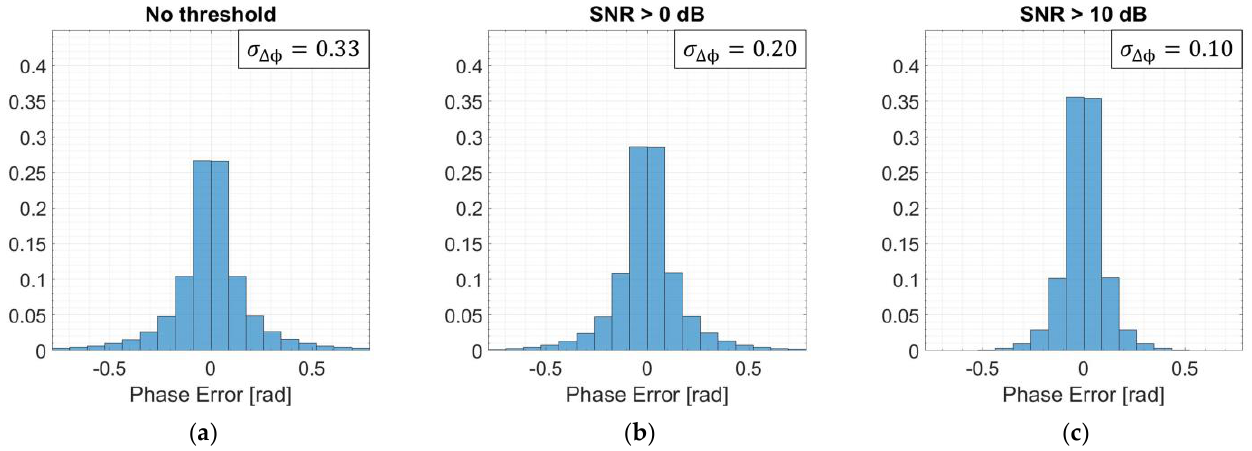
Figure 14. Histogram of the phase error for the 2D FFBP image with 𝐿 = 5 and an (8 × 4 × 1) initial partition for ( a ) no signal-to-noise ratio (SNR) threshold, ( b ) SNR >0 dB, and ( c ) SNR >10 dB.